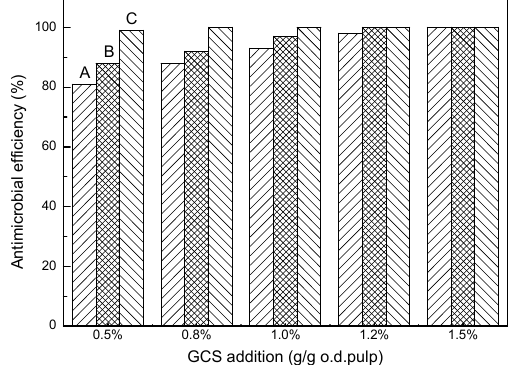
Figure 7. Effects of addition amount of GCS on the antimicrobial efficiency (equilibrium adsorption).